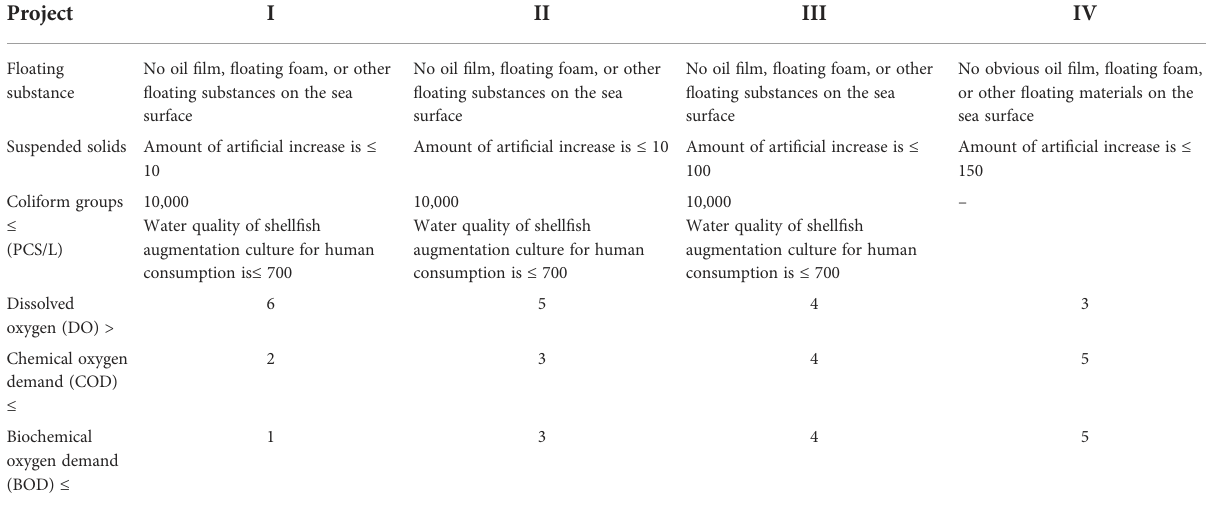
TABLE 5 Sea water quality standards